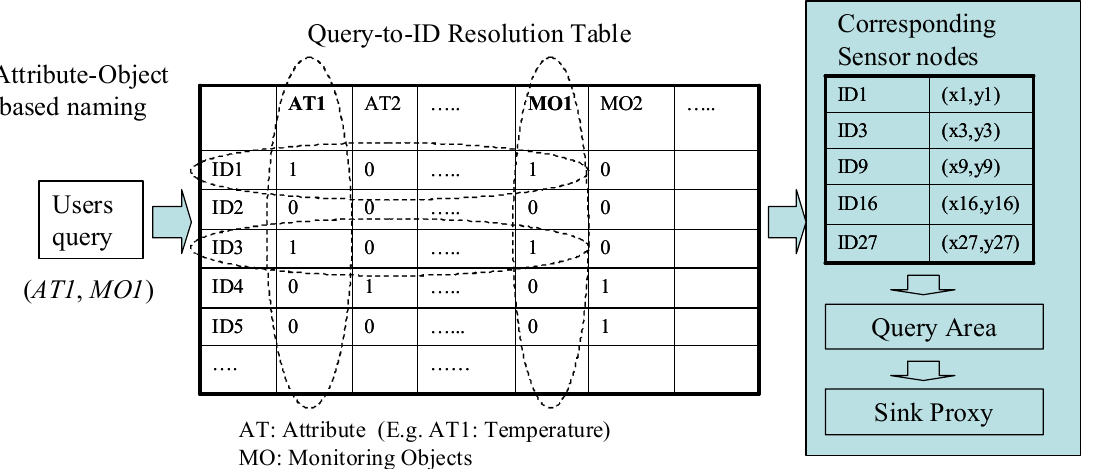
Figure 1. Query to IDs